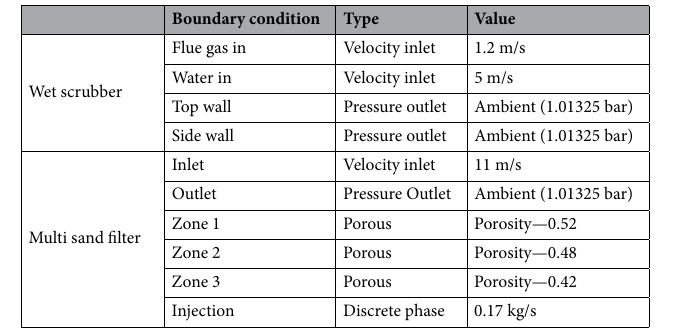
Table 1. Boundary condition for wet scrubber and multi sand filter.